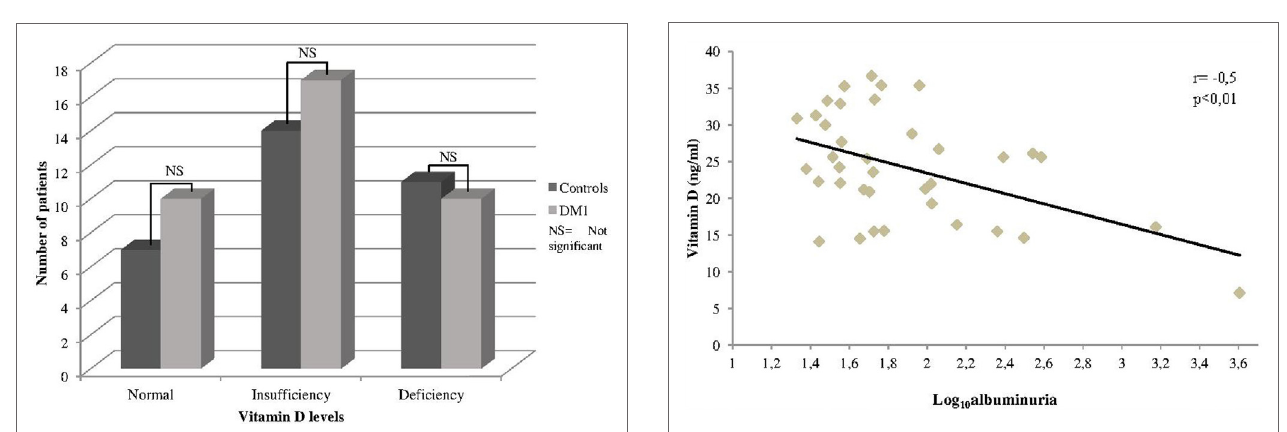
FigUre 1 | status according to VD levels in T1DM and controls .